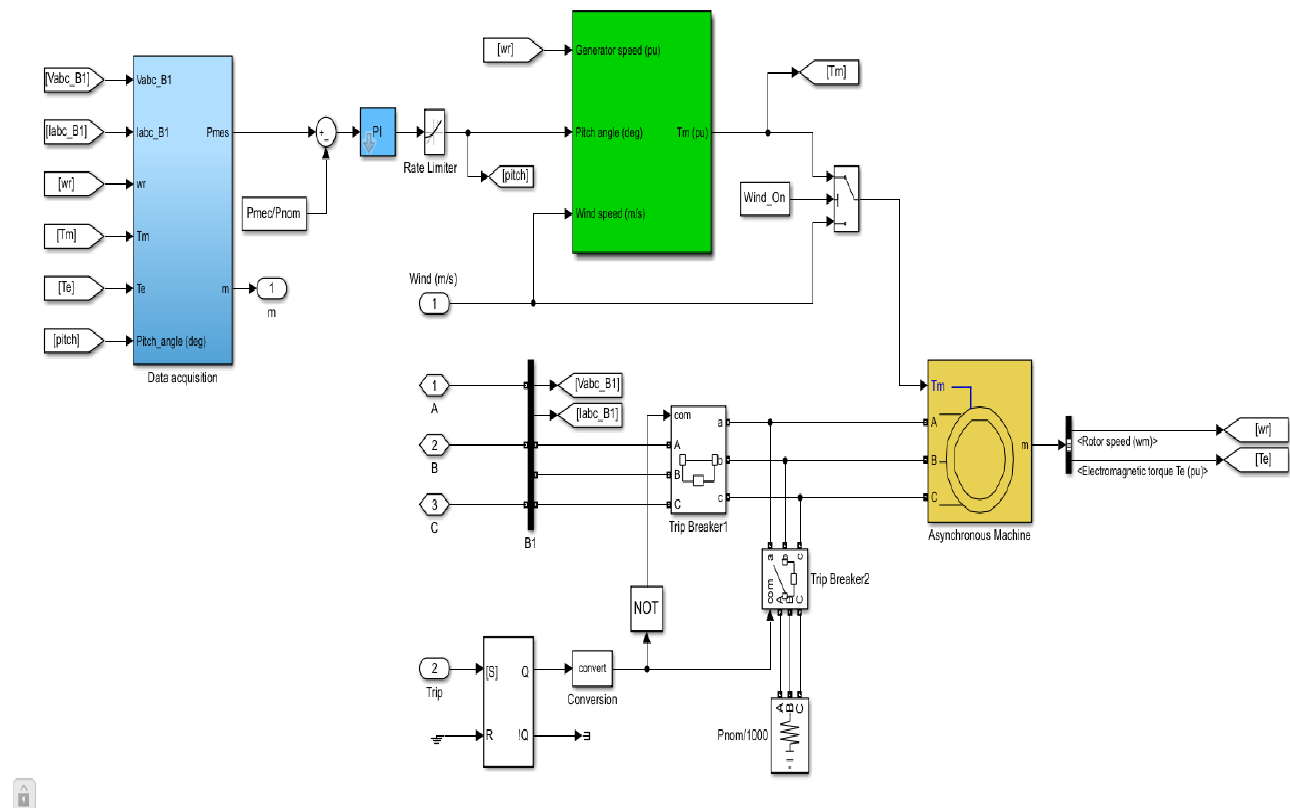
Figure 4. Simulink model of SCIG wind turbine connected to a grid network .